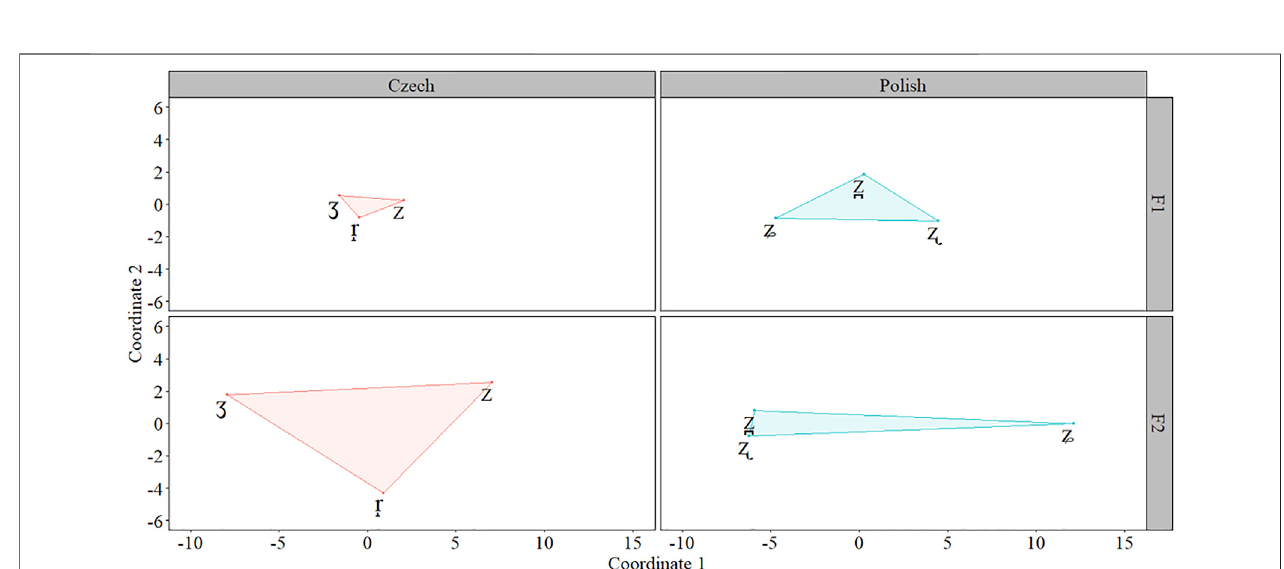
FIGURE 8 | Multidimensional Scaling for the F1 and F2 measures for Czech (red) and Polish (blue) sibilants.